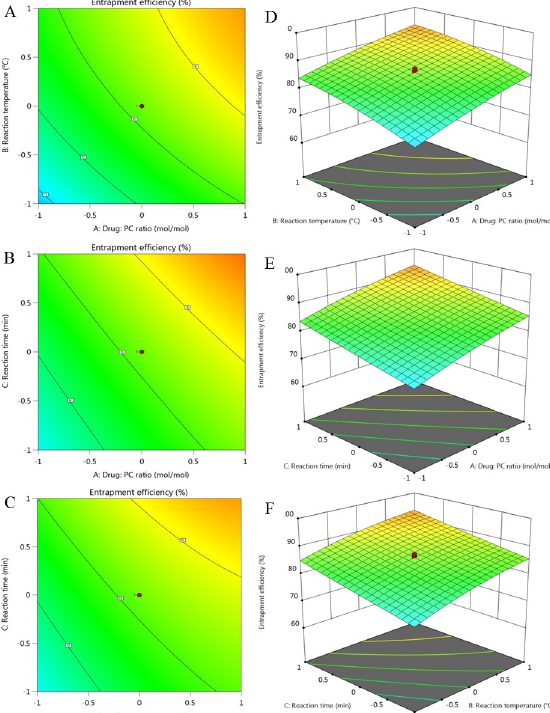
Fig 1. 2D counter plots (A-C) and 3D surface plots (D-F) showing the effects of independent variables on EE (%).